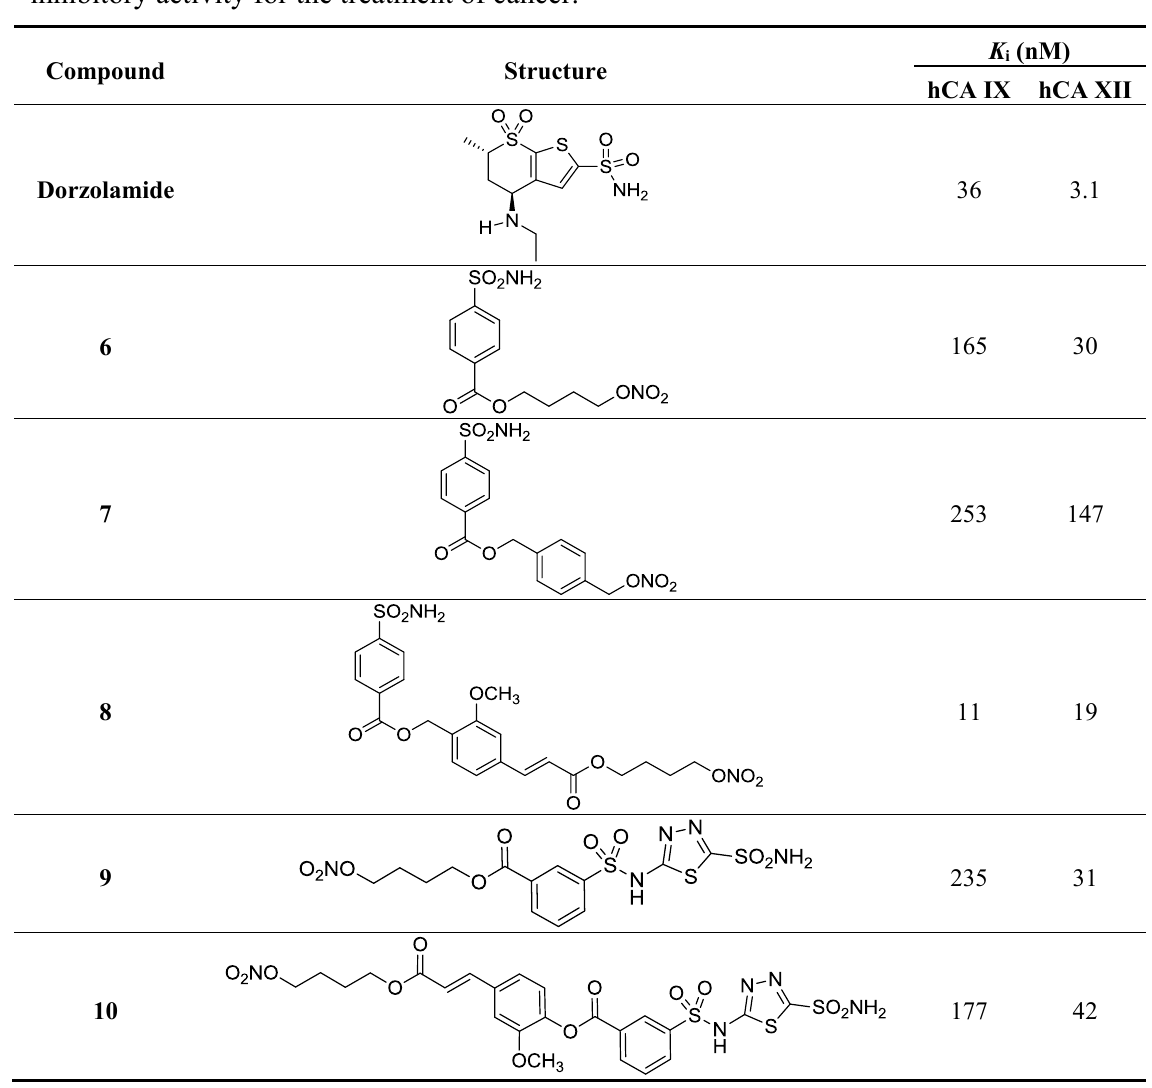
Table 2. Dual agents endowed with NO donating properties and selective hCA isoform inhibitory activity for the treatment of